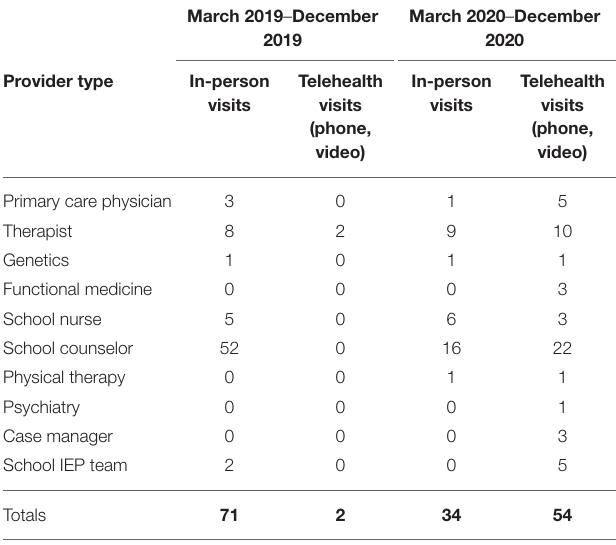
TABLE 1 | Comparison of number and type of in-person and telehealth visits, March–December 2019 and 2020, for a pediatric patient with hypermobile Ehlers-Danios Syndrome